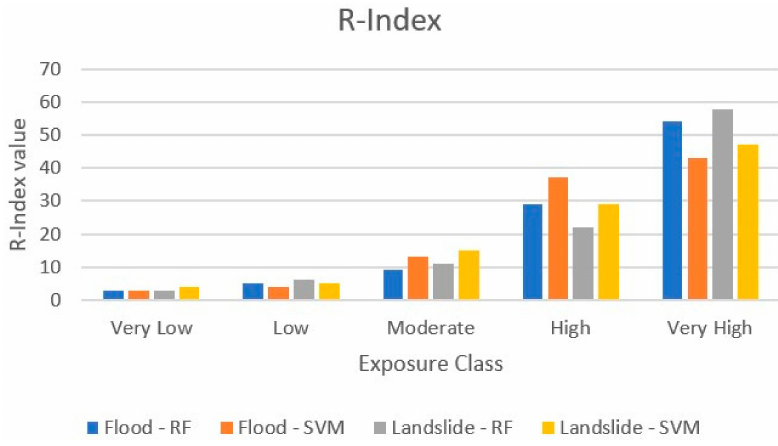
Figure 9. R-index values for flood and landslide using RF and